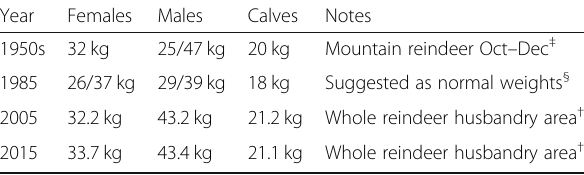
Table 1 Average carcass weight (kg) of slaughtered reindeer recorded from the 1950s until